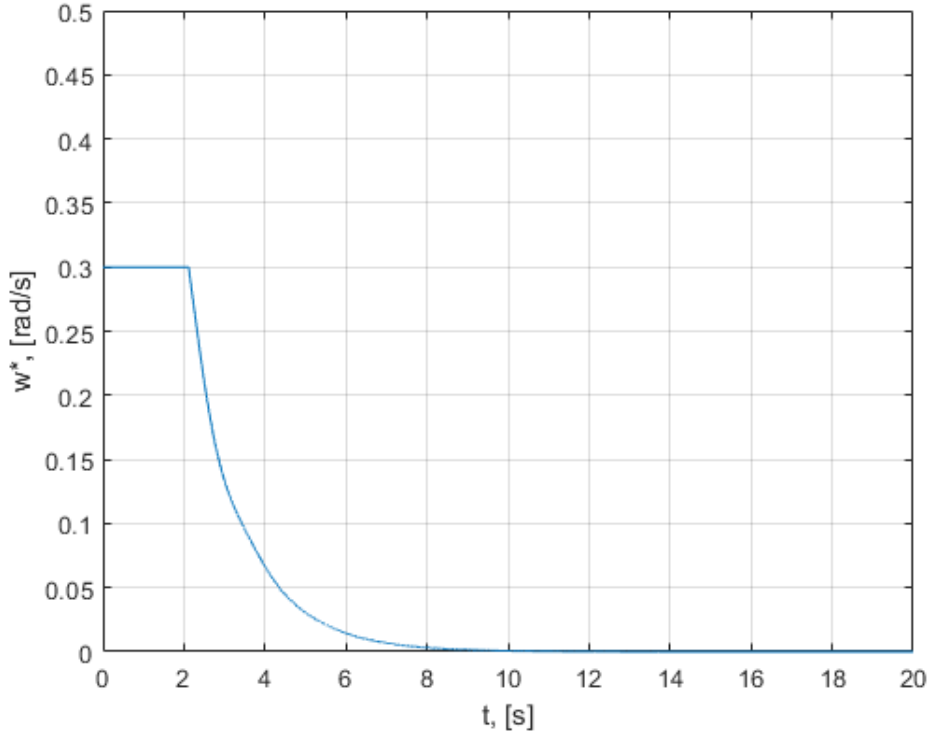
Figure A5. The speed reference of digital control system.